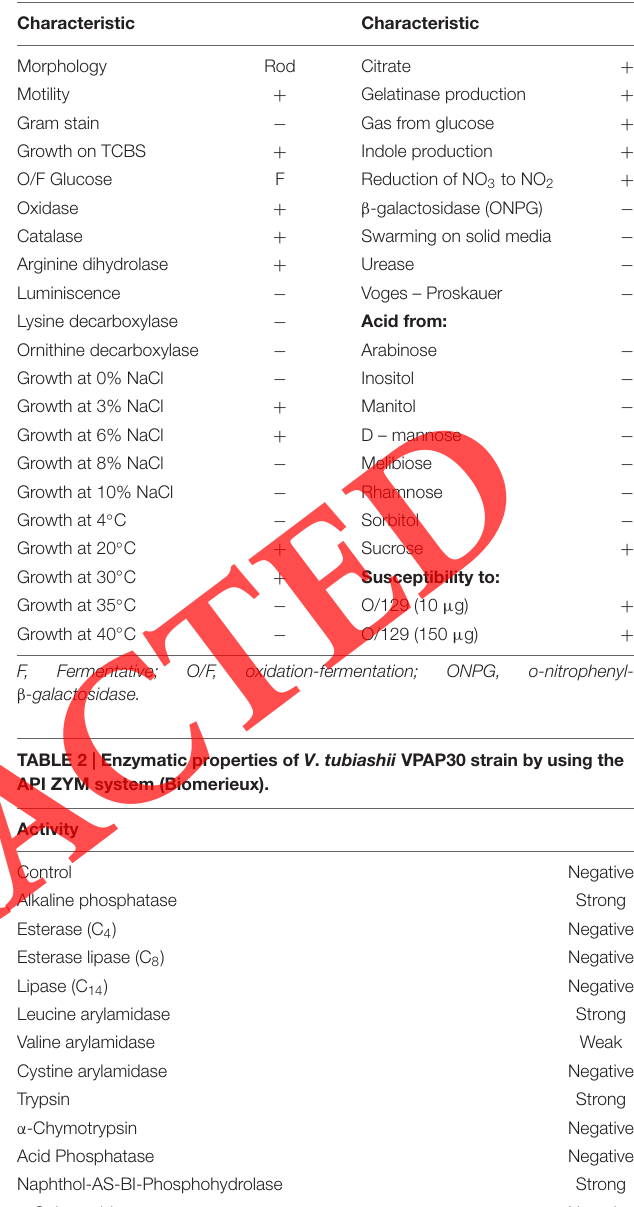
TABLE 1 | Phenotypic characteristics of Vibrio tubiashii VPAP30.